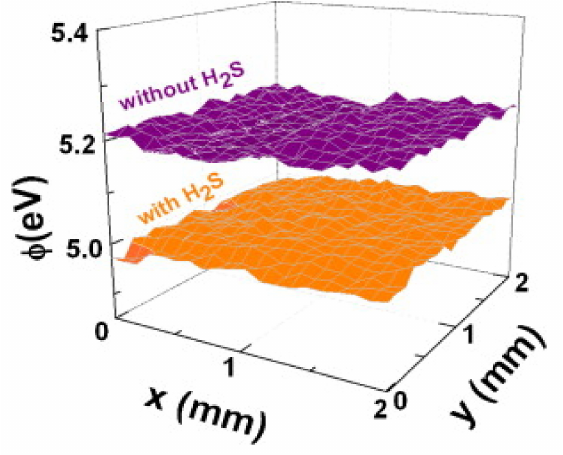
Figure 12. Change in work function of CuO-modified WO 3 films in the presence of 50 ppm H 2 S. Reprinted from [87] with permission from Elsevier.